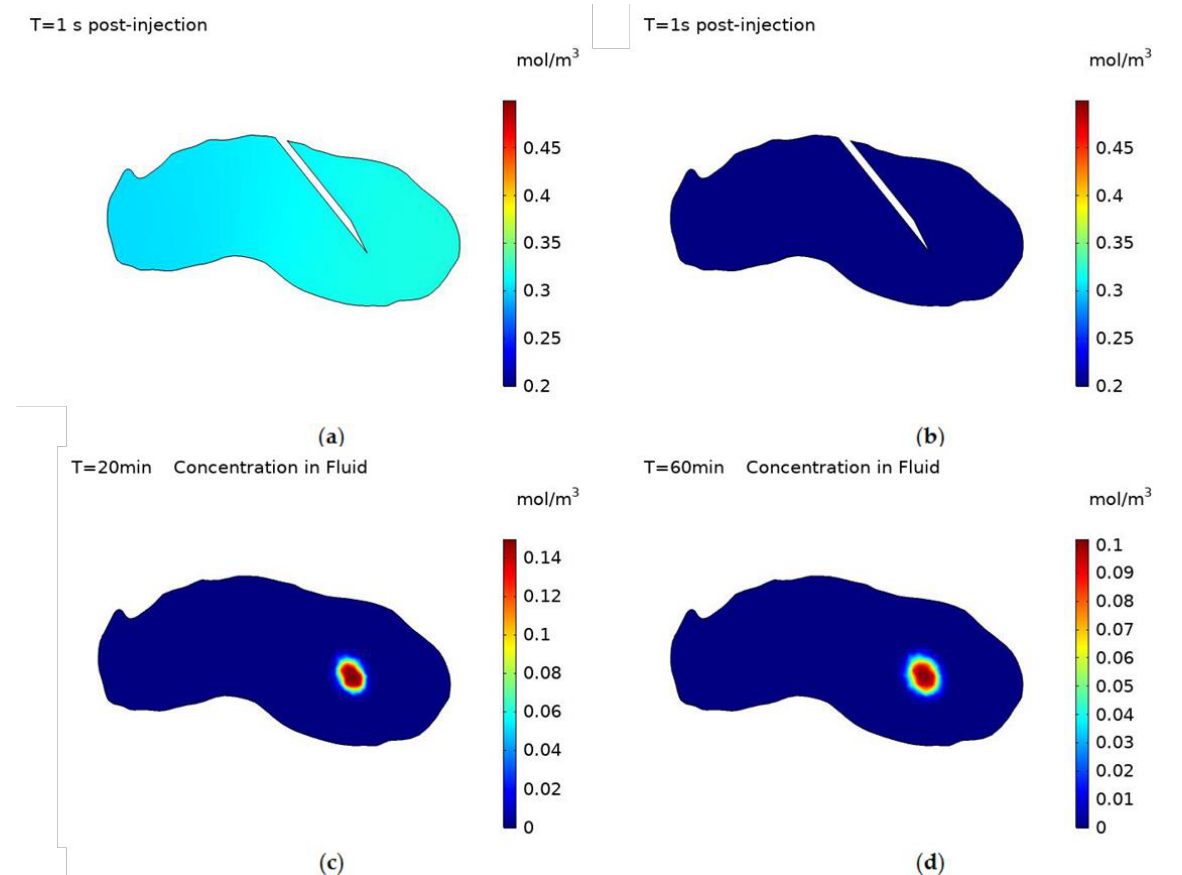
Figure 7. Concentration contours of nanoparticles within the fluid with surface charges; ( a ) − 30 mV, ( b ) +30 mV, at 1 s post-injection and for uncharged particles at; ( c ) 20 min and, ( d ) 60 min post-injection.